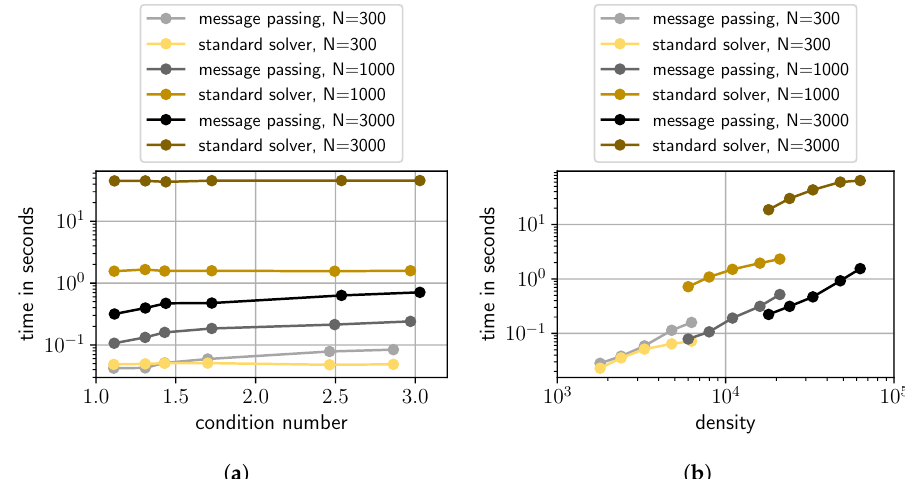
Figure 14. The plots show the required time of our Message Passing Algorithm to achieve a result for the LESs better than 10 − 5 . The times are compared to the time of a standard solver. The standard solver and the Message Passing Algorithm were running on the Zynq UltraScale board. In ( a ), the times are shown for the set of LESs with constant density. In ( b ), the times are shown for LESs with constant condition number. Both sets of LESs contain matrices with dimensions 300, 1000, and 3000. The computation times are plotted with respect to the condition number in ( a ) and with respect to the density in ( b ).